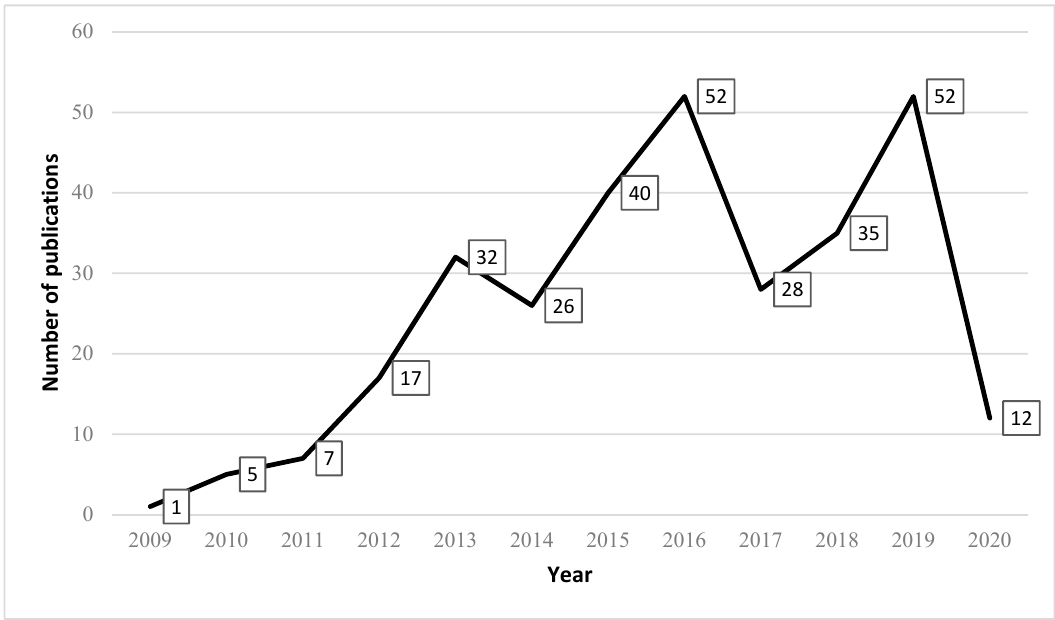
Figure 1. Number of publications in research on energy efficiency in cloud computing (2009–2020). Source: authors’ own study. Data sourced from Scopus (20 May